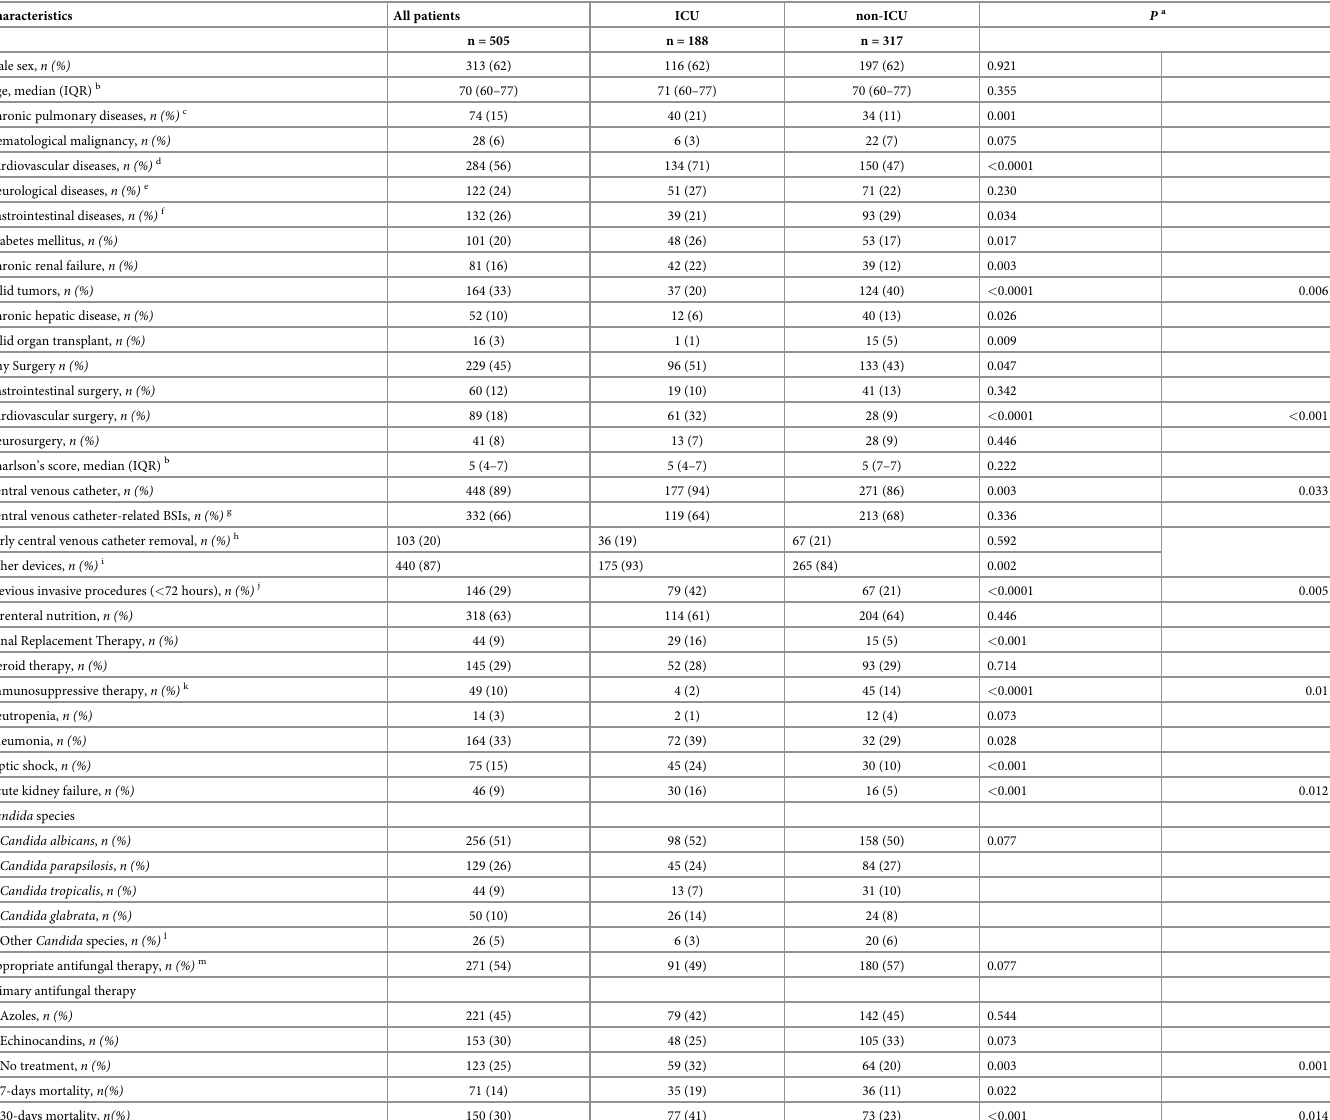
Table 1. Demographic and clinical characteristics of patients included in the